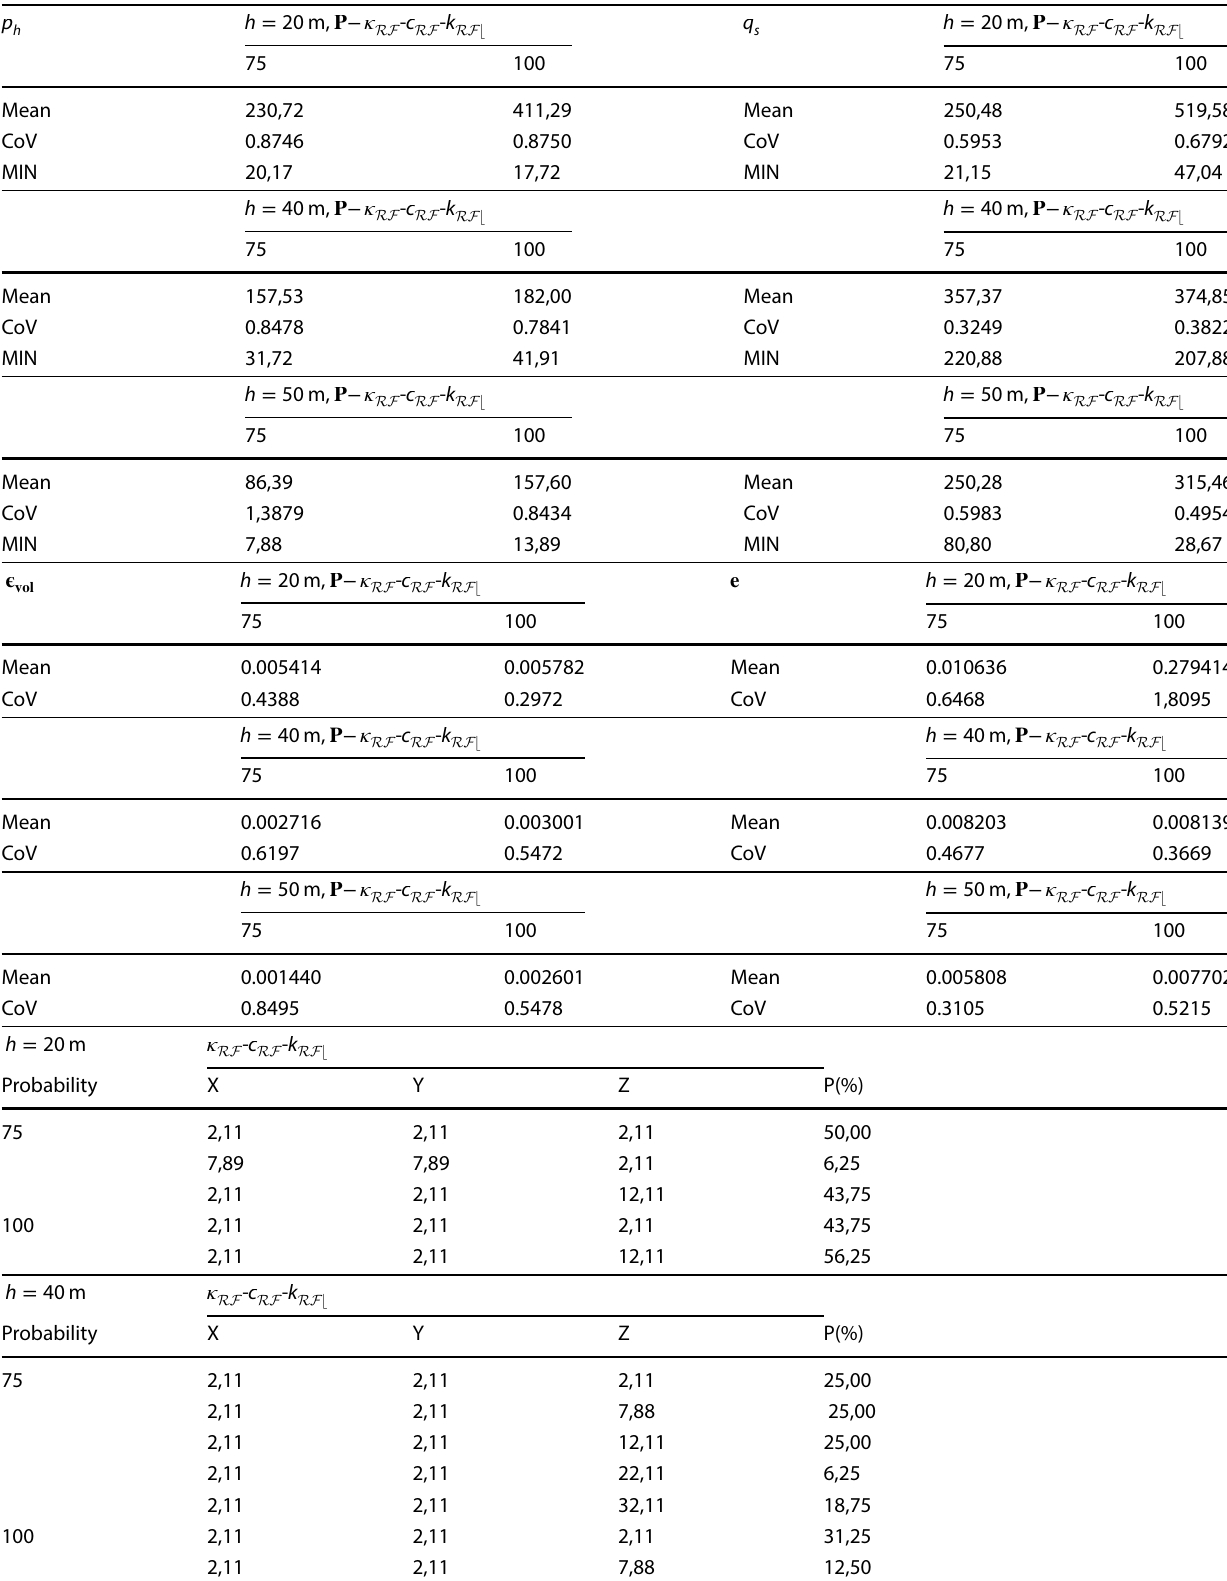
Table 11 Monte Carlo results for the stresses (KPa), the strains and the probability of the first Gauss point failure for porous analyses with random field representation for all stochastic material variables p